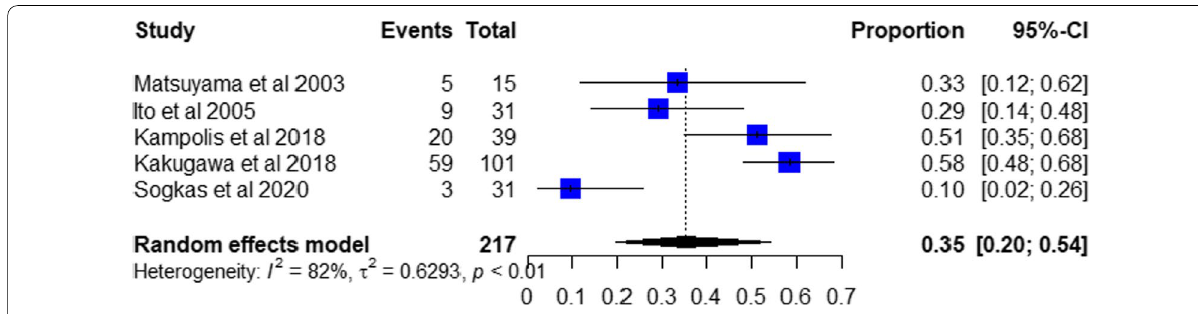
Fig. 10 Meta‑analysis of the Bronchiolitis in patients with Sjogren’s syndrome